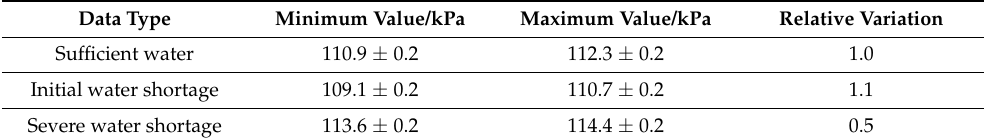
Table 1. Change parameters and amplitude of leaf turgor pressure under different water conditions.